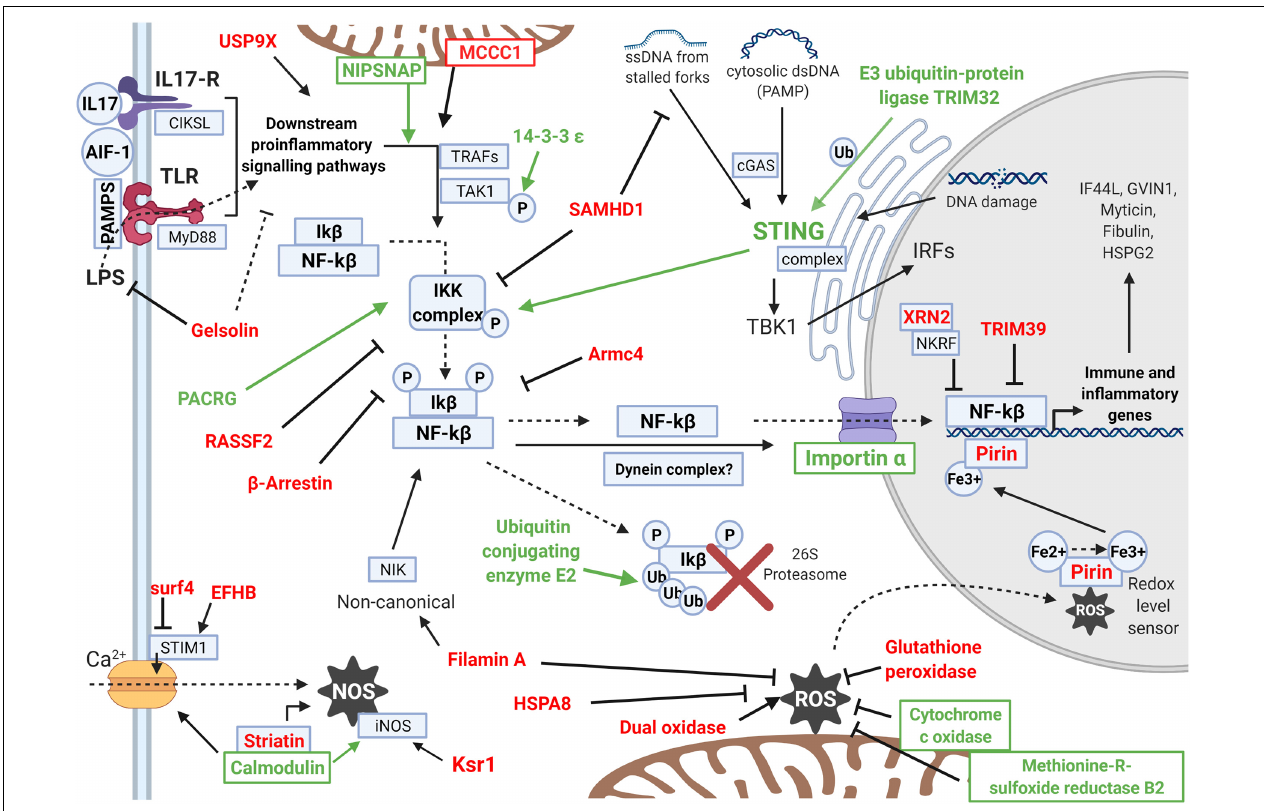
FIGURE 5 | Scheme showing the differentially expressed proteins (DEPs) that regulate the intracellular inflammatory NF-kB pathway and the oxidative and calcium regulation response. The names of the upregulated DEPs are indicated in green, while downregulated DEPs are indicated in red. The activity that each protein exerts is represented with arrows if it is an activation or with an inhibition sign if it is an inhibitory protein. The pathway represented in the scheme follows the same order that is explained in the Discussion. Proteins with functions enhancing the NF-kB pathway were generally upregulated (green), while inhibitory proteins were downregulated in the experiment (red). The scheme shows how the NF-kB response is activated and the oxidative stress is maintained under